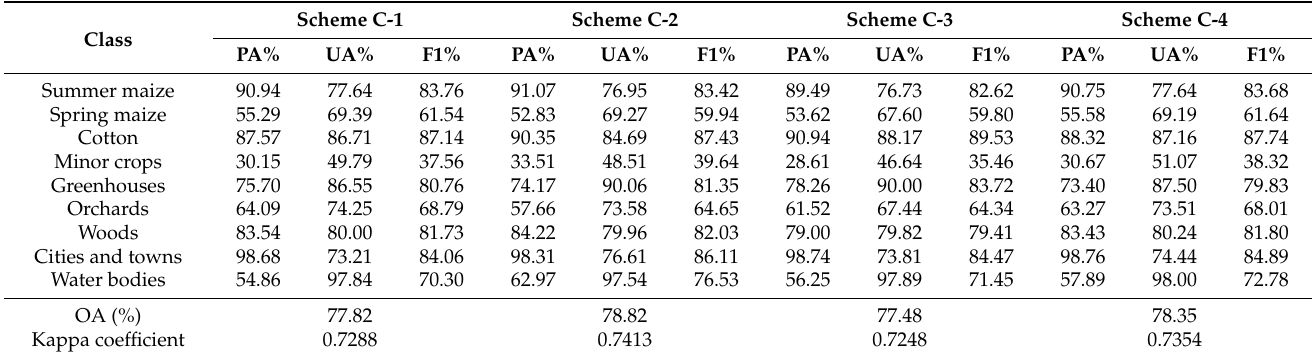
Table 9. Classification accuracy statistics of red edge index features.